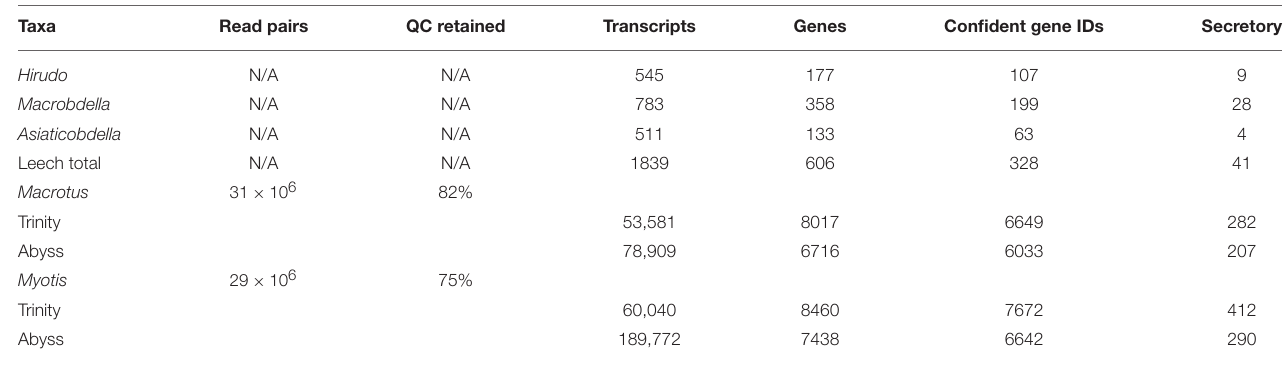
TABLE 1 | Assembly and annotation